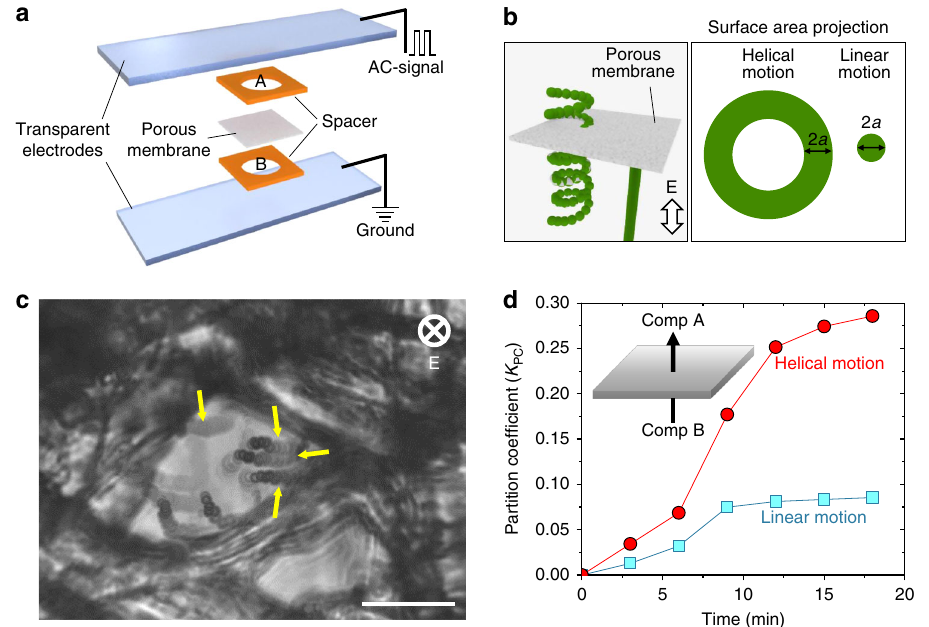
Fig. 6 Unique ability of helically propelled active colloids to tunnel through crowded matrices. a Schematic of the experimental setup used for particle tunneling experiments. Initially the patchy particles were con fi ned only into compartment B, and their tunneling into compartment A through a porous membrane was monitored and quanti fi ed using a light microscope. The AC-electric fi eld was applied normal to the plane of porous membrane. b Schematics representing the helical and linear propulsion of particles through the membrane, and projected area of the particle trajectories on the membrane. c Microscope image showing the tunneling of several helically propelled particles through a crosslinked cellulose matrix. Here E = 260 V cm − 1 at 10 kHz, a = 1 μ m, and φ = 10°. The arrows indicate the particle trajectories. d Increase in the fraction of particle penetrating through the porous membrane i.e., partition coef fi cient with time. The circles represent the helically propelling patchy particles and squared are linearly propelled particles. Scale bar in c is 20 µ